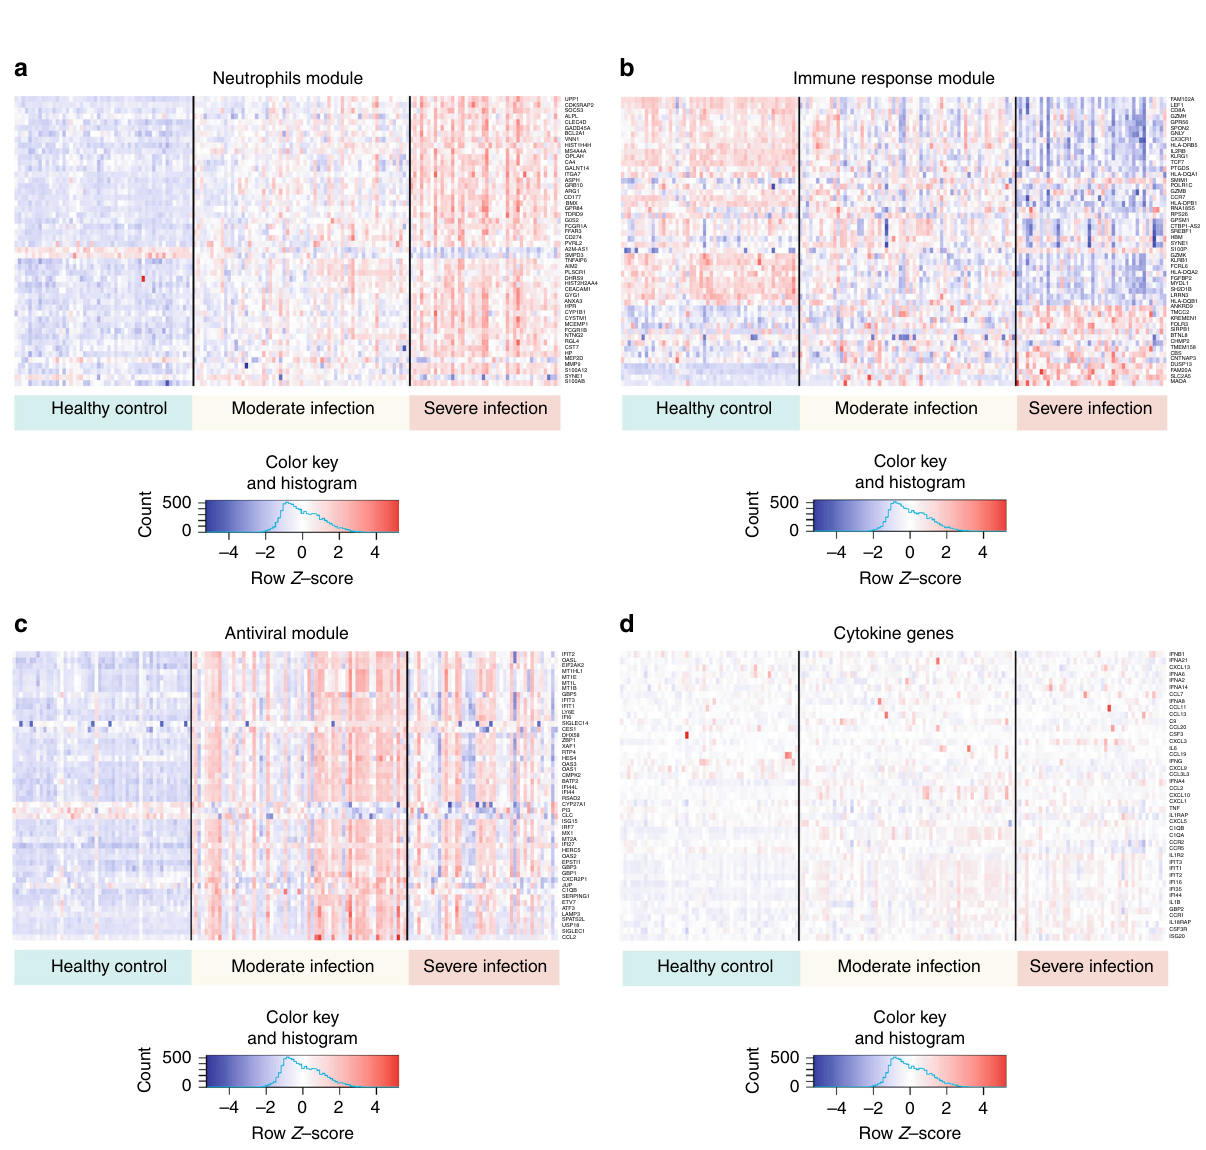
Fig. 4 Neutrophils, immune response, antiviral modules, and cytokines heat maps. a Neutrophils module. b Immune response module. c Antiviral module. d Cytokine genes. Genes were sorted according to the calculated variance (high to low) and were clustered according to similarity in expression levels. Patients were grouped into control, moderate, and severe groups. The top 50 genes with the highest variance are presented in these heat maps. The source data are available in Gene Expression Omnibus (GSE